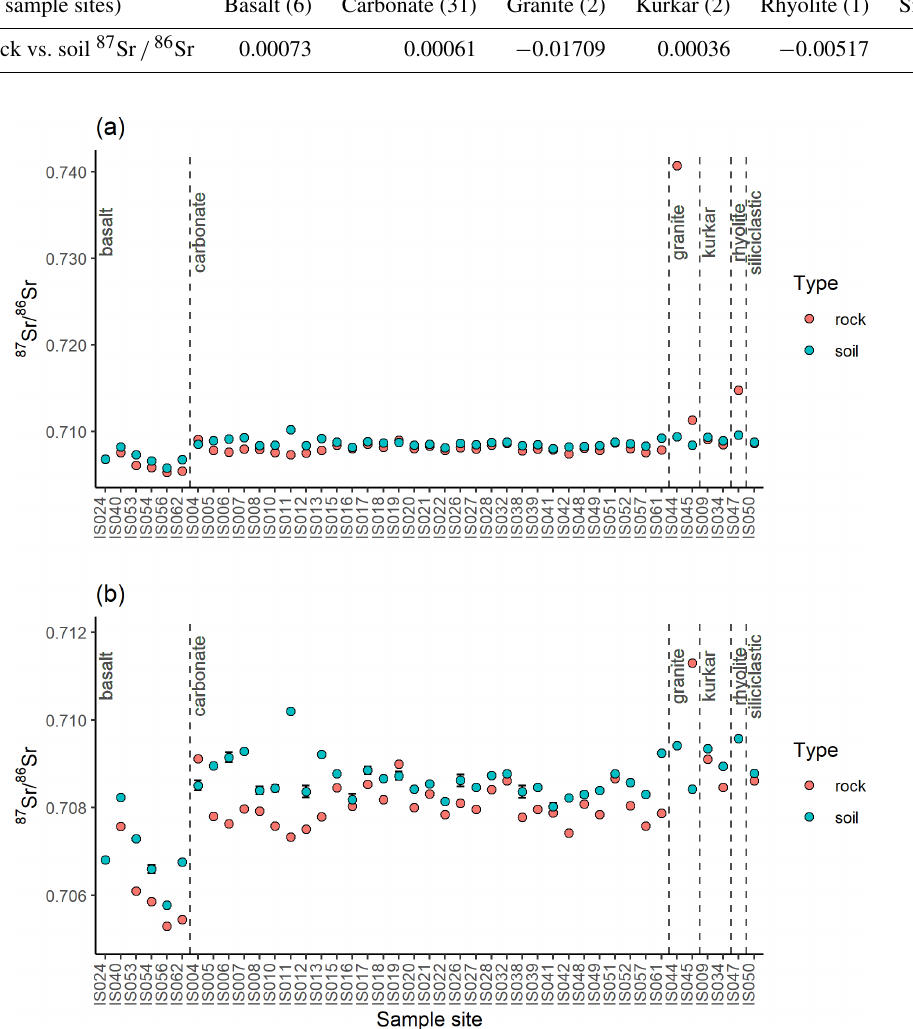
Figure 5. Bioavailable 87 Sr / 86 Sr of rock and soil samples collected from the same sample locations displayed with 2 σ error bars. Sample locations are grouped based on gross lithology observed in the field. (a) All data, (b) subset of data with high 87 Sr / 86 Sr granite sample (site IS044) and rhyolite sample (site IS047) removed to display variability between other